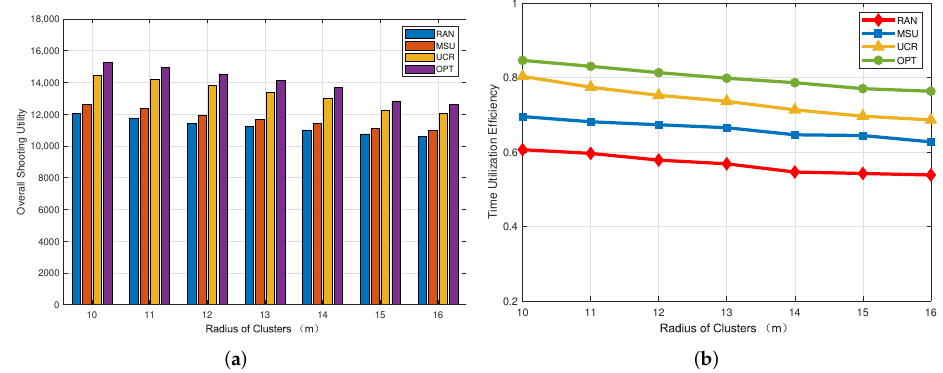
Figure 4. Impact of the number of cluster heads. ( a ) Overall shooting utility; ( b ) Time utilization efficiency.